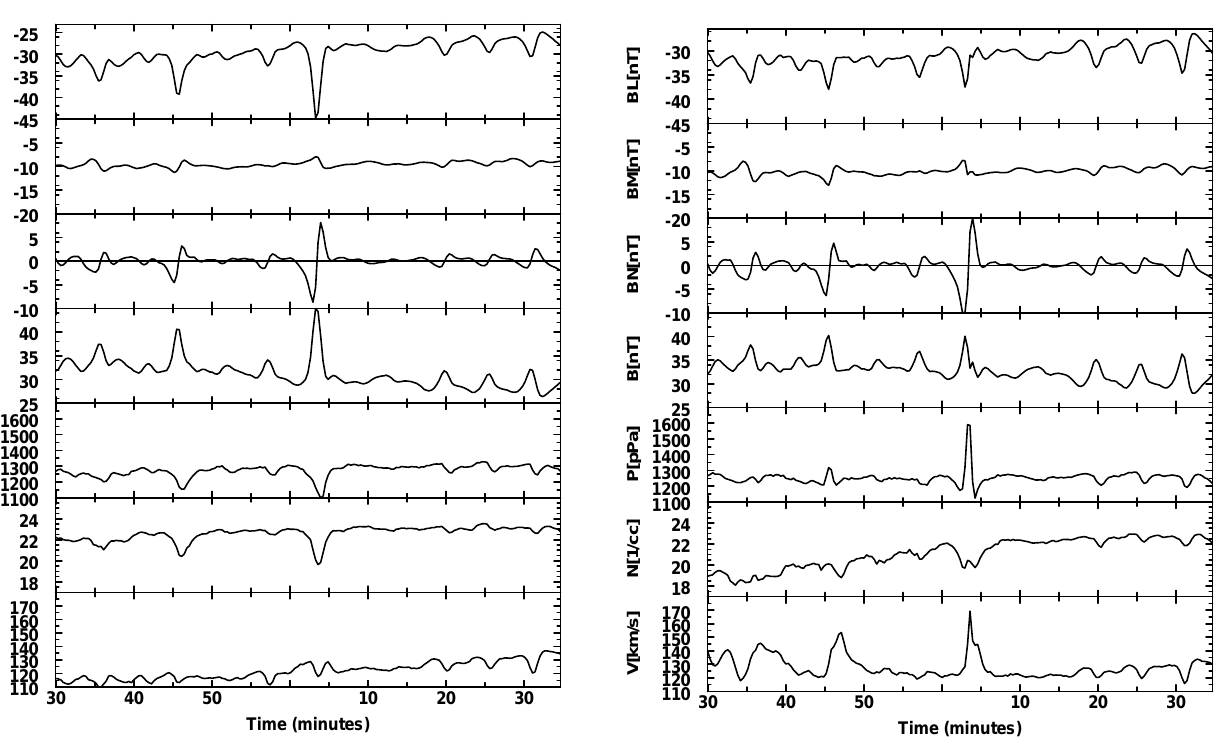
Fig. 6. Same as Fig. 4, except that the traces are taken 0.2 R E fur- ther outward, at 9.8 R E